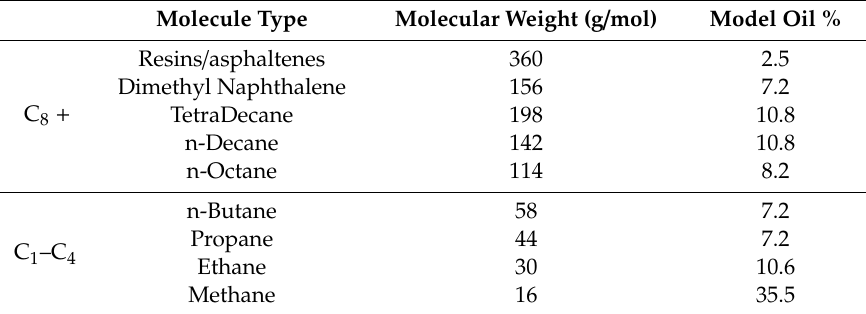
Table 1. Composition of model oil.